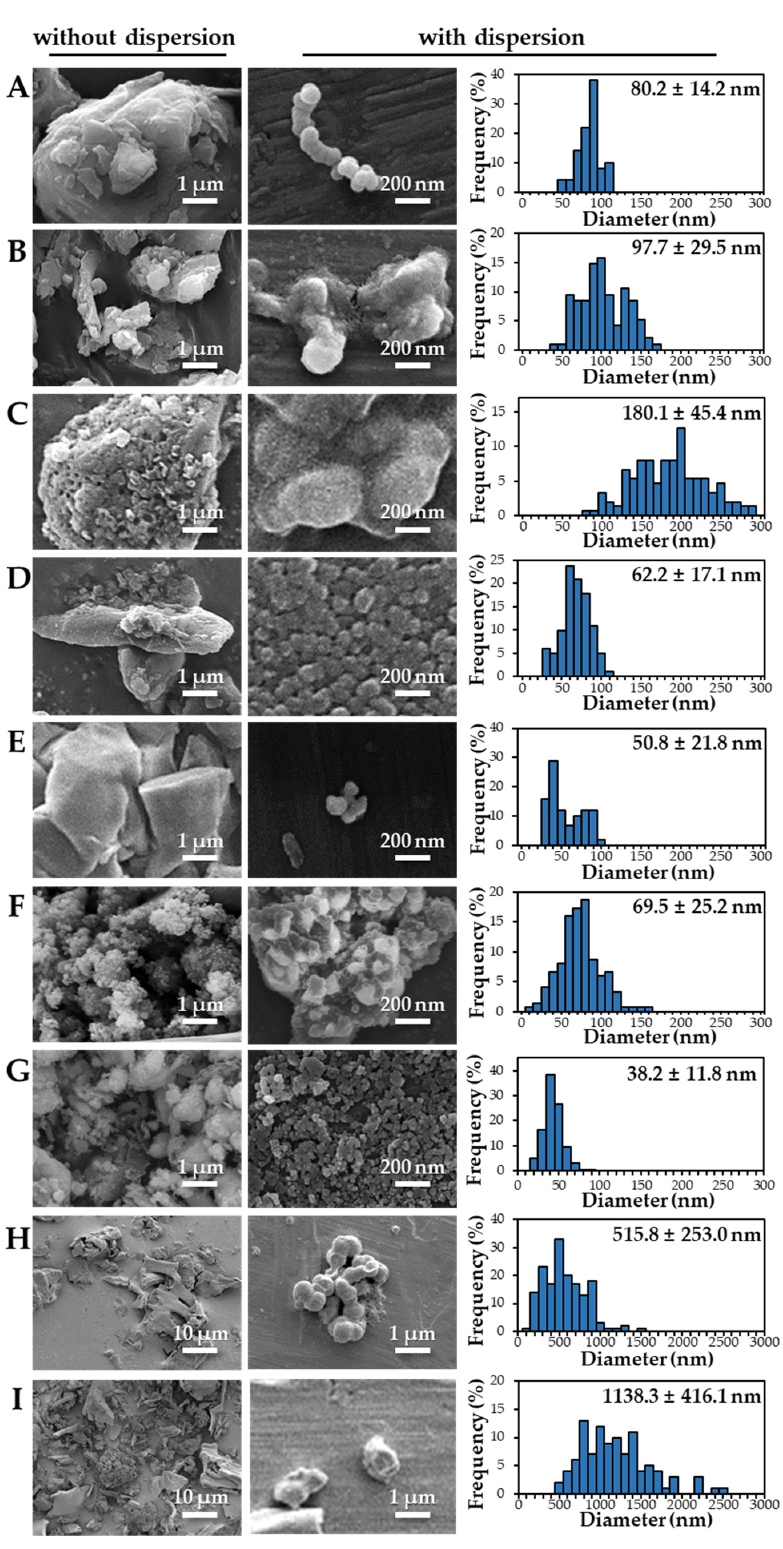
Figure 1. Scanning electron microscopy (SEM) images and size distributions of TD-NPs or conven- tional bulk-sized BP-1 and BP-2 composed of the same components as NP-1 and NP-2, respectively. ( A ) NP-1, ( B ) NP-2, ( C ) NP-3, ( D ) NP-4, ( E ) NP-5, ( F ) NP-6, ( G ) NP-7, ( H ) BP-1, and ( I ) BP-2. The size distributions of constituent particles were determined by randomly selecting more than 100 parti- cles from the SEM images. Abbreviations: TD-NP, top-down-approach-produced nanoparticle; BP, bulk-sized particle; NP,